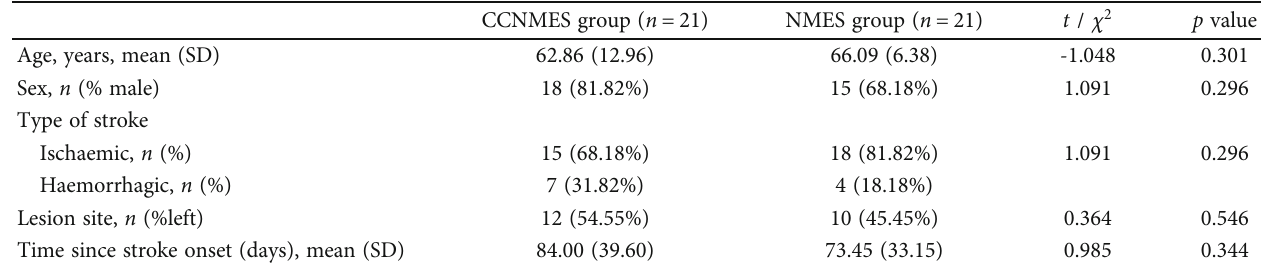
Figure 2: CONSORT fl ow diagram. Table 1: Clinicodemographic data of the study cohort at